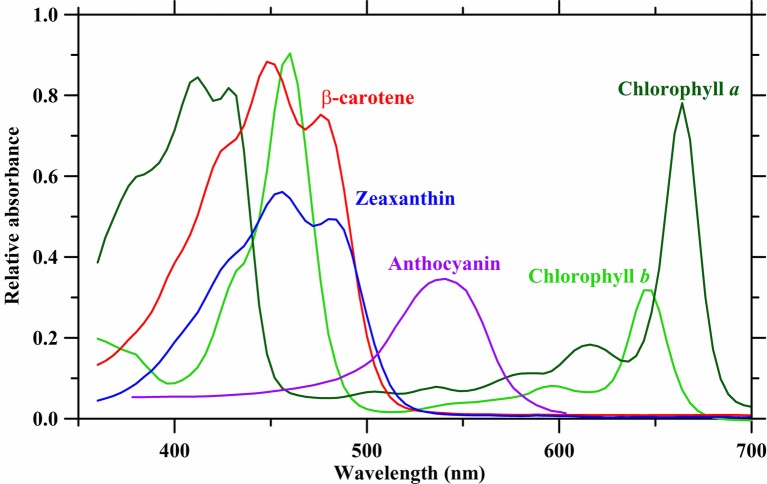
Absorbance spectra of plant photosynthetic pigments in acetone. Absorbance data are derived from Taiz and Zeiger (2002), Avital et al. (2006), Heddad et al. (2006), and Kobayashi et al. (2013).